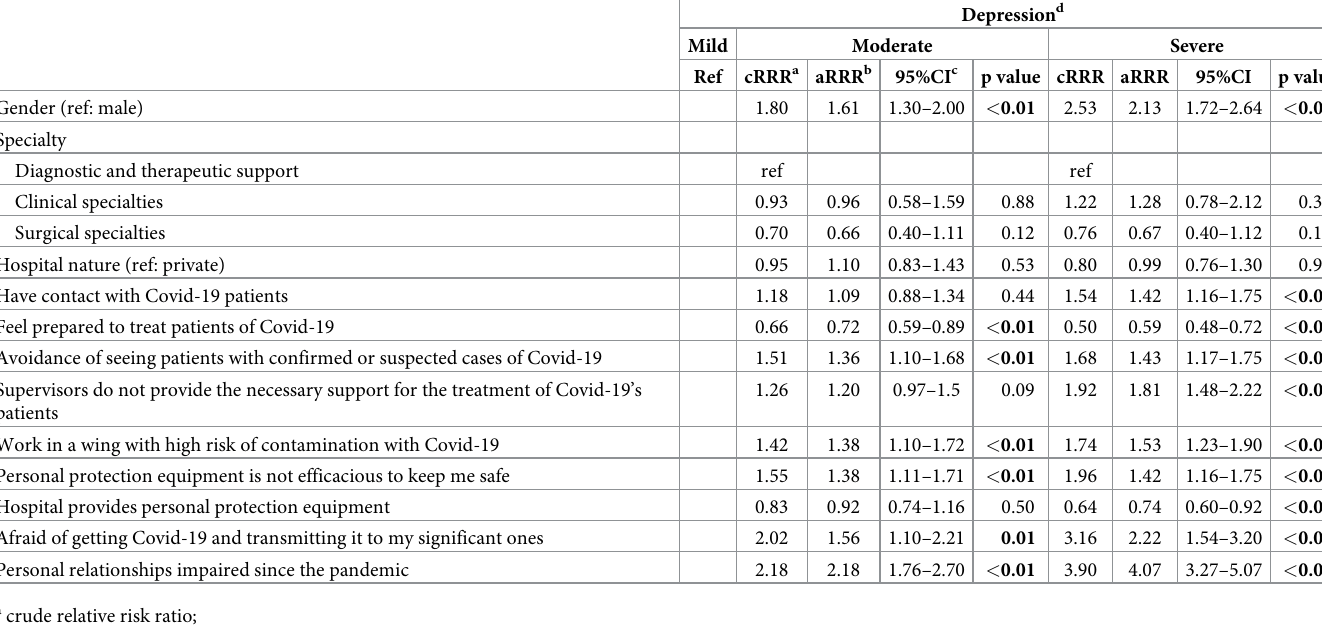
Table 3. Multinomial logistic regression model of depressive symptoms among 3071 residents from Brazil,